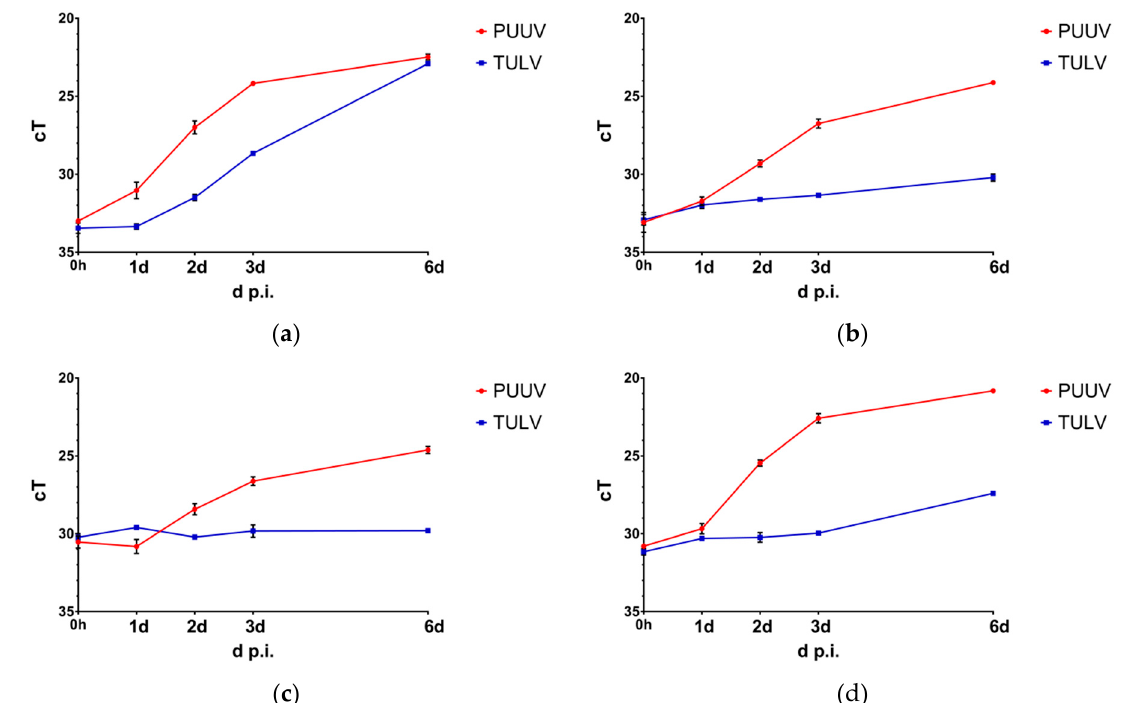
Figure 1. Quantification of viral RNA. The amplification of viral RNAs in supernatants of Puumala virus (PUUV)- and Tula virus (TULV)-infected ( a ) Vero E6, ( b ) A549, ( c ) HMEC-1, and ( d ) THP-1 / PMA cells was quantified by means of qRT-PCR analysis of viral RNA copies in cell-free cell culture supernatants. Cells were infected with a multiplicity of infection (MoI) = 0.1 and viral RNA copies were quantified at 0 h, 1 d, 2 d, 3 d, and 6 d post infection.